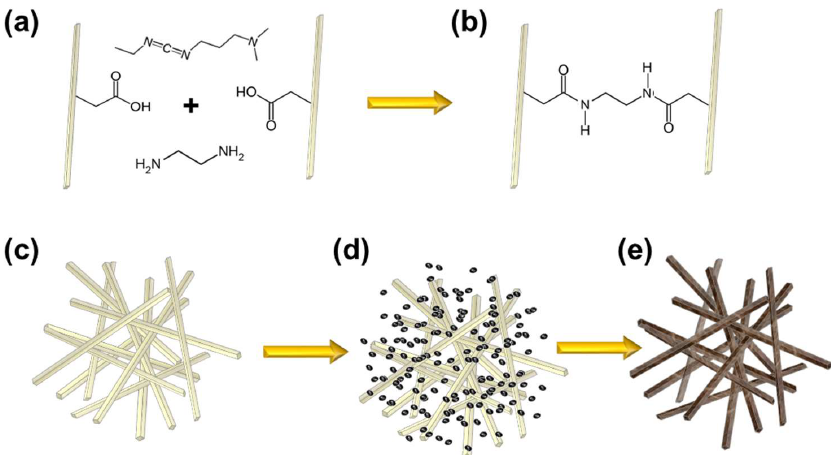
Figure 1. Aerogel synthesis scheme. ( a ) cross linking carboxymethyl cellulose nanofibers (CNF) with EDC and ethylenediamine as a linker molecule; ( b ),( c ) cross-linked carboxymethyl cellulose nanofibers; ( d ) CNF hydrogel equilibrated with palladium salt solution; ( e ) CNF biotemplated palladium composite aerogel after reduction with NaBH 4 , rinsing, solvent exchange with ethanol, and supercritical drying.